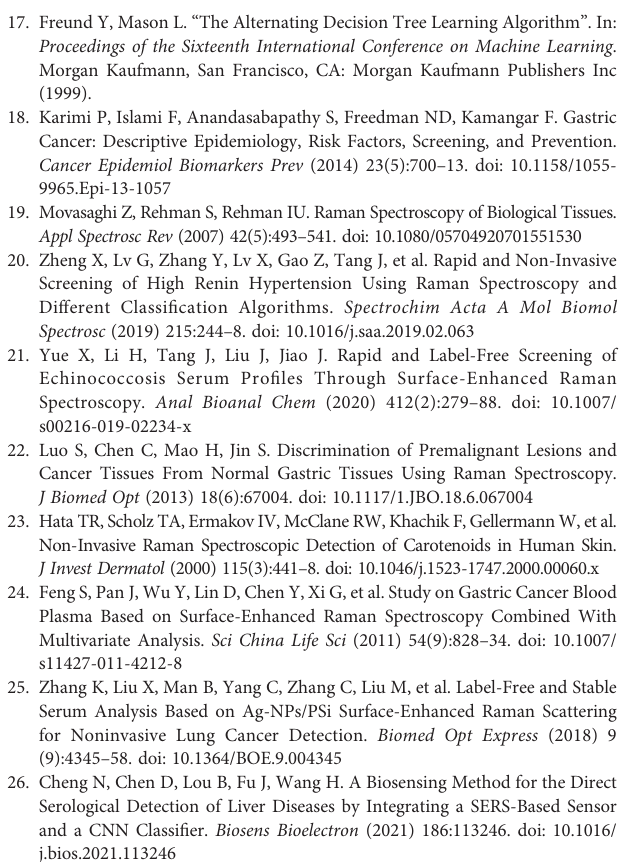
Supplementary Figure 1 | The accuracy-epoch curves (A) and loss-epoch curves (B) of the One-dimensional convolutional neural network (1D-CNN) model. Supplementary Figure 2 | The distribution of prediction probability in different machine learning algorithms. Each light blue box represents the normal probability and the light yellow box indicates the GC probability. The orange line shows the median value of sample distribution, and the green triangleshows the meanvalue of sample distribution. The whole box reveals the prediction probability range of test samples in 95% con fi dence intervals. And the maximum and minimum values in the distribution space are displayed at the top and bottom of each box plot, respectively. In particular, the red dots represent outlier samples in every distribution